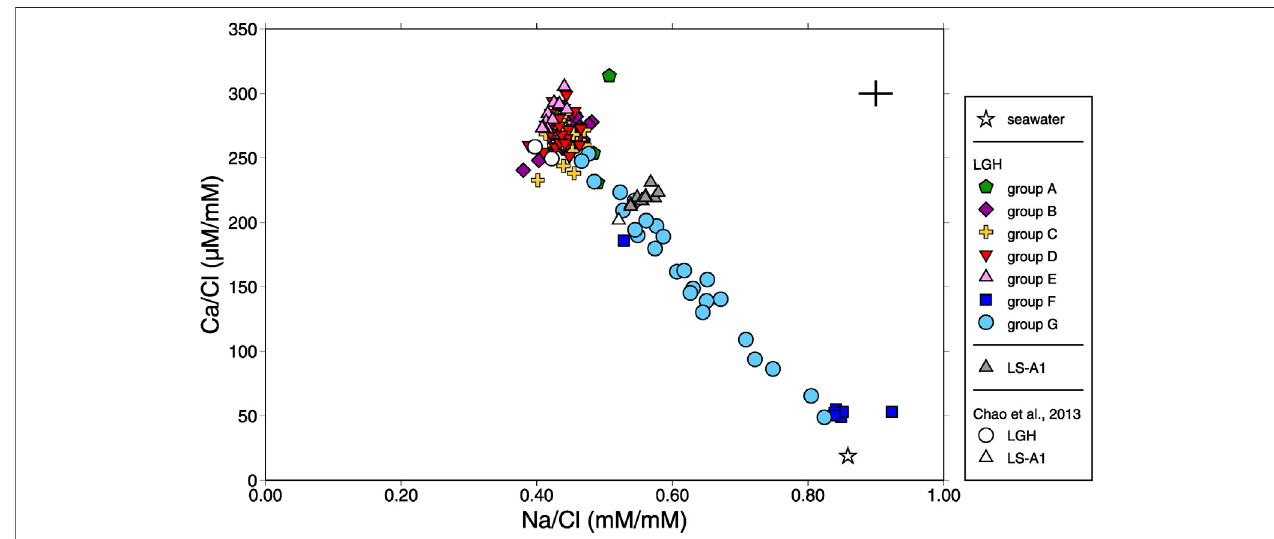
FIGURE 2 | Plot of Ca/Cl ratio vs. Na/Cl ratio for all mud volcano fl uids in this study. Previous report (Chao et al., 2013) and seawater composition are shown for reference. The range of the cross denotes the range of the reproducibility (2 σ ).